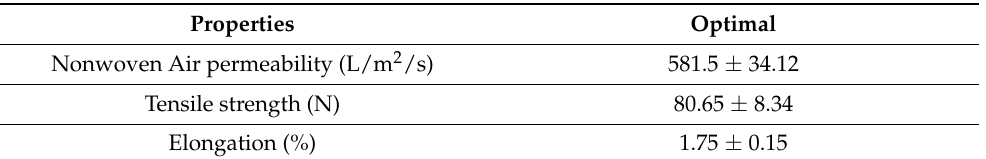
Table 6. Properties of the nonwovens obtained by the wet process under optimal manufacturing conditions.